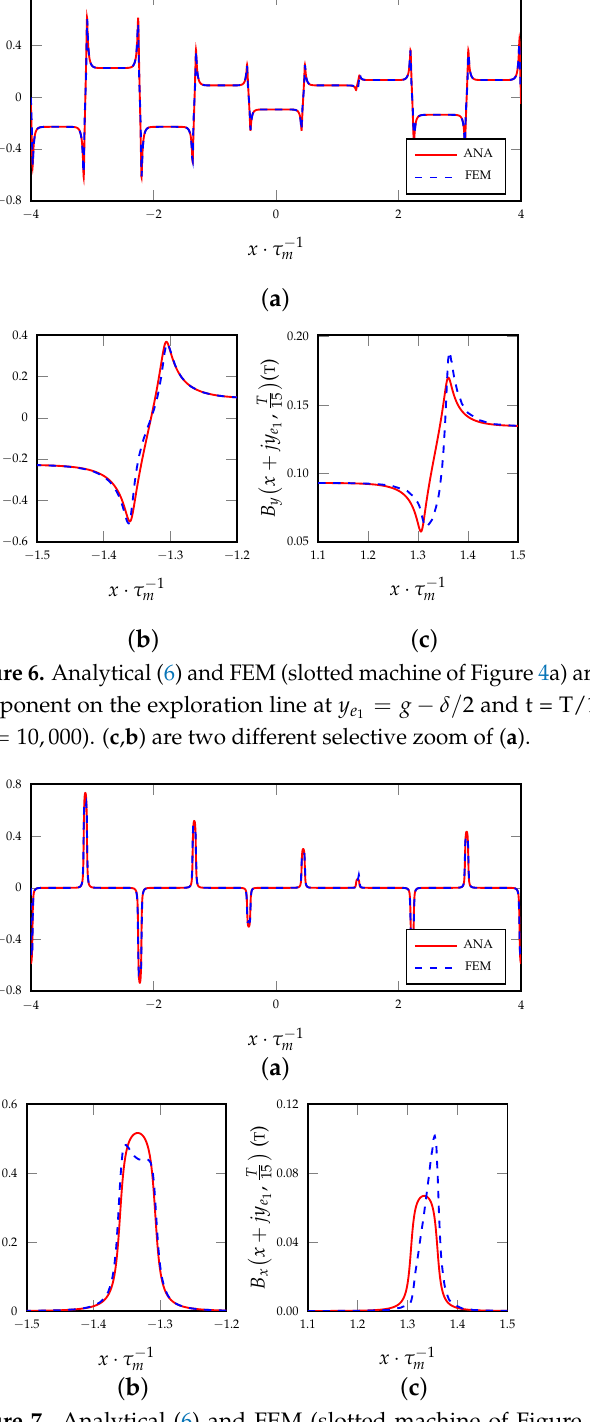
= g − δ / 2 and t = T/15 ( I = 105.5 A , − 4 τ m ≤ x ≤ pk 1